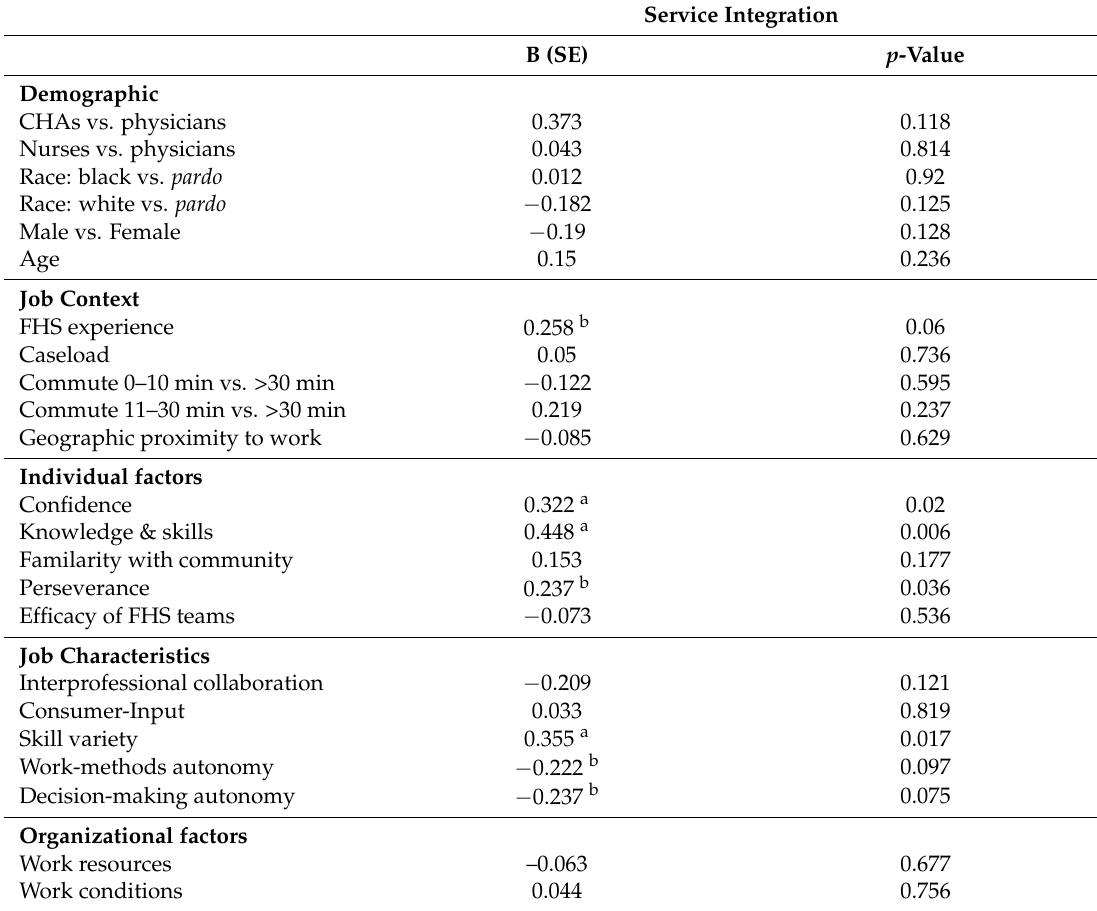
Table 3. Standardized estimated direct effects from fully-adjusted structural equation